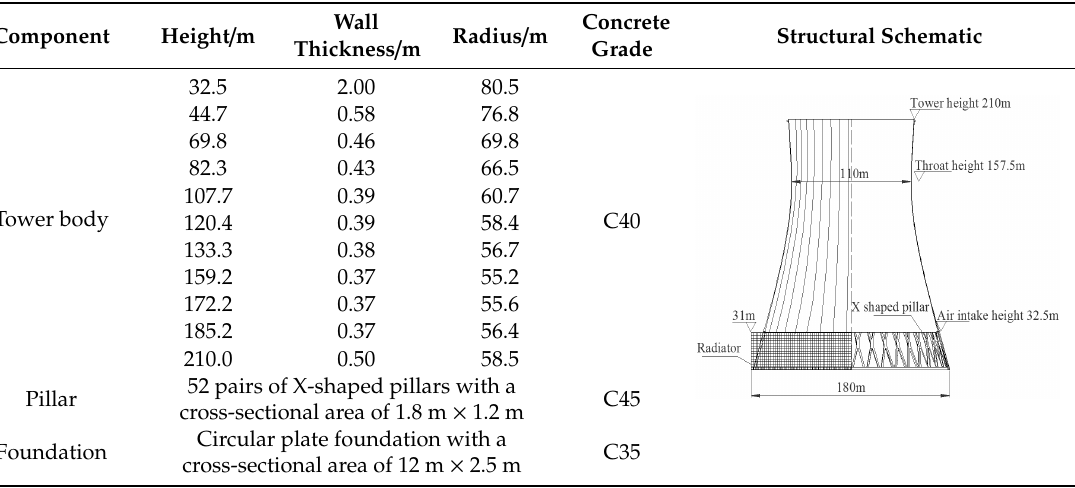
Table 1. Main structural parameters of super large cooling tower.